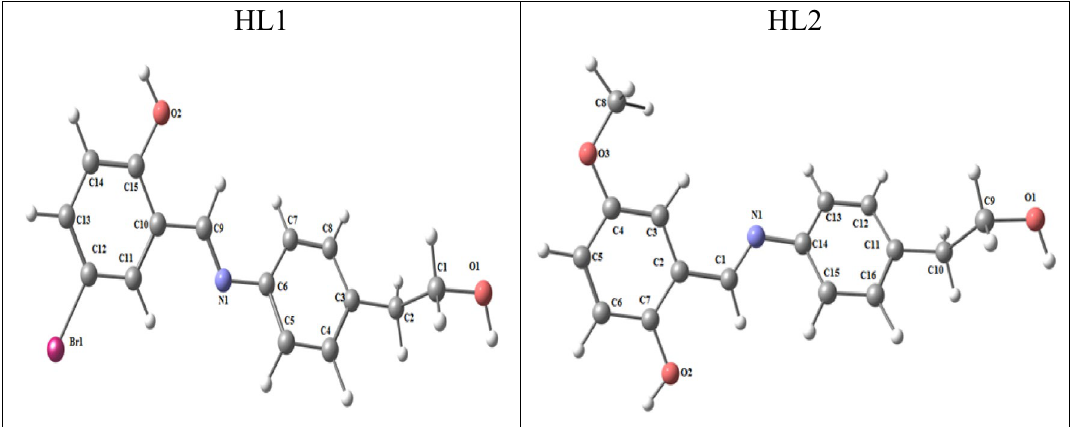
Figure 5. The natural charges on active centers as well as the HL1and HL2 optimal structures.